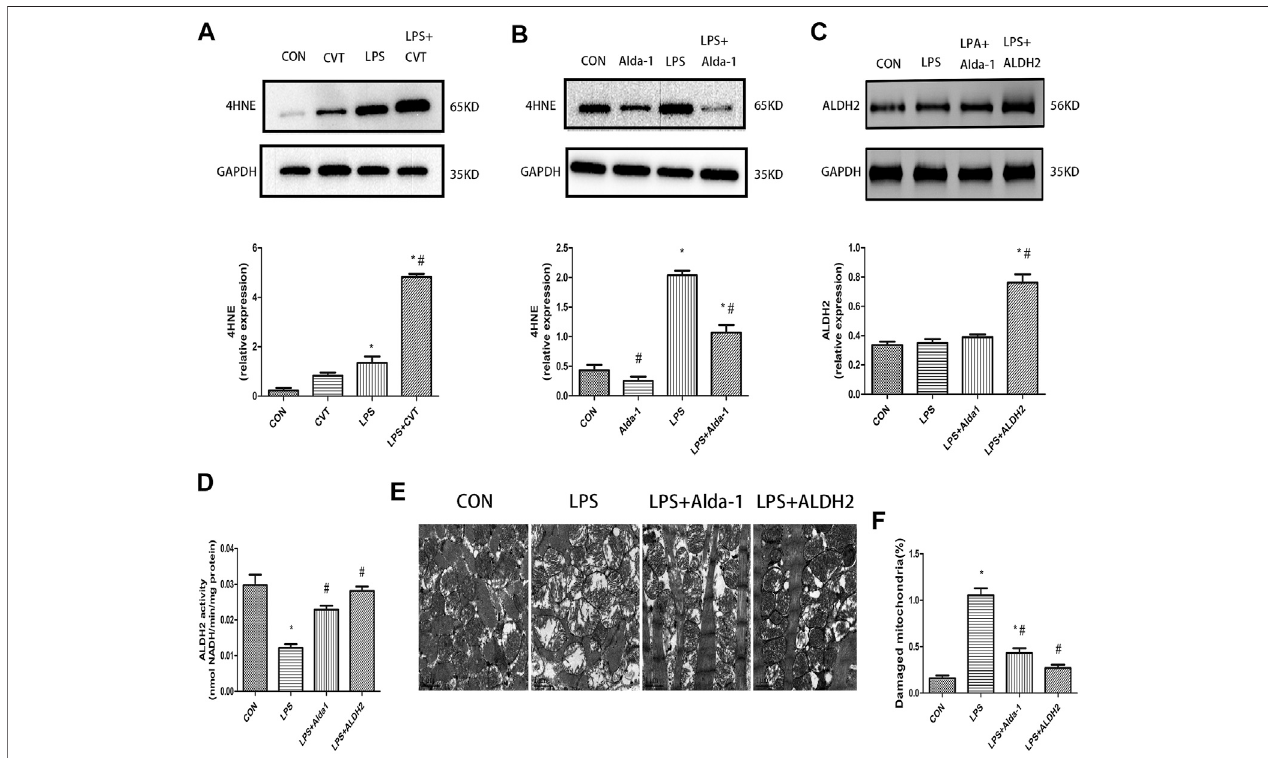
FIGURE 5 | 4-Hydroxy-trans-2-nonenal (4HNE) accumulation, aldehyde dehydrogenase 2 (ALDH2) activity and expression, and ultrastructural changes in lipopolysaccharide (LPS)-treated mice (A,B) Representative western blots and quanti fi cation analysis of 4HNE and glyceraldehyde 3-phosphate dehydrogenase (GAPDH; loading control). (C) Representative western blots and quanti fi cation analysis of ALDH2 and GAPDH (loading control). (D) Quanti fi cation of ALDH2 enzymatic activity. (E) Representative transmission electron microscopy (TEM) images from four mouse groups. Scale bar: 1 µm. (F) Quanti fi cation analysis of damaged mitochondria. Data are the mean ± standard error of the mean. n (cid:1) 3 mice/group. Statistical analyses were performed by one-way analysis of variance, followed by Tukey ’ s post hoc test for multiple comparisons. * p < 0.05 vs. control (CON); # p < 0.05 vs. LPS.